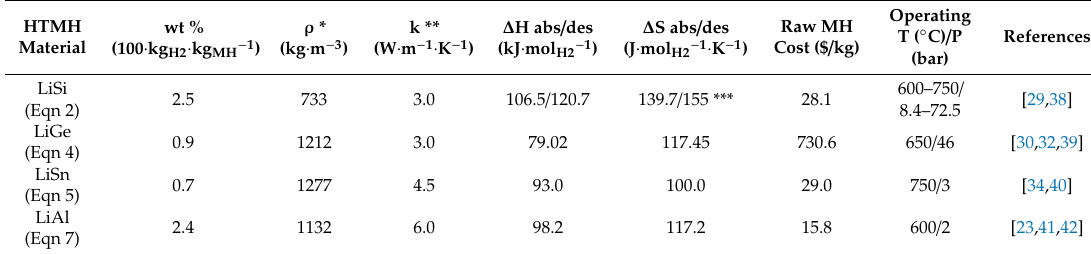
Table 2. Destabilized Li material